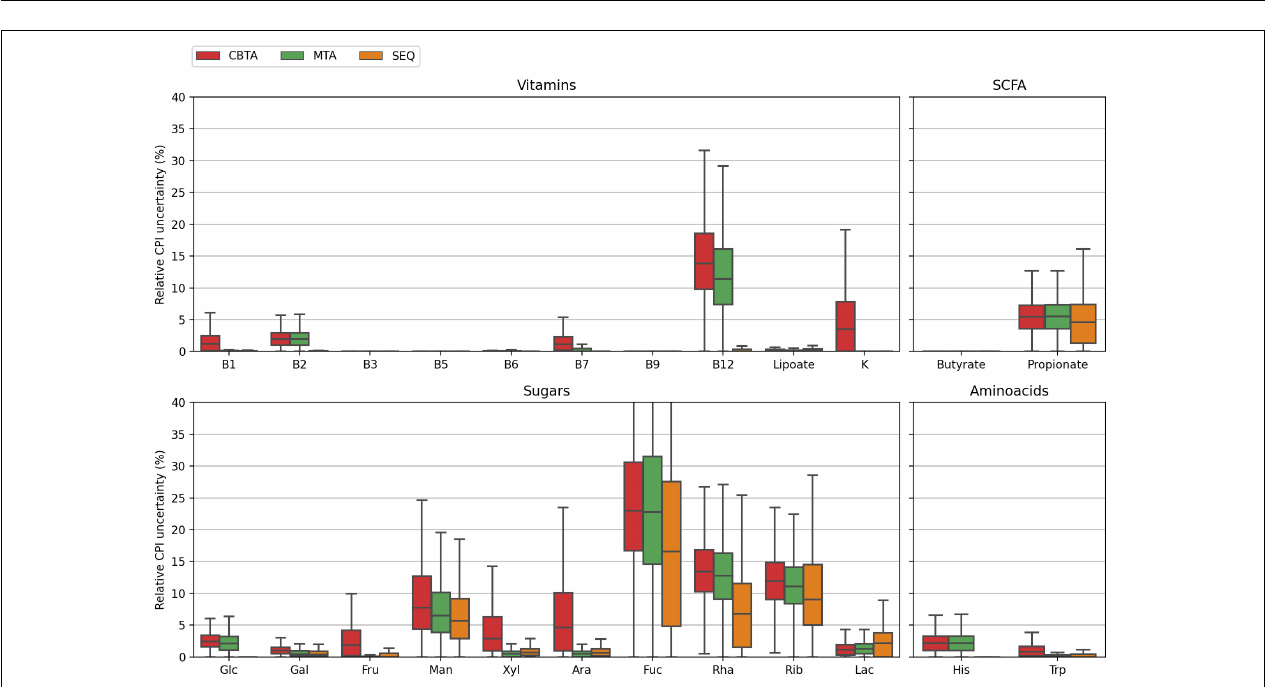
FIGURE 4 | Distributions of the relative CPI prediction uncertainties calculated for 1,000 in silico generated mock communities using three mapping schemes.